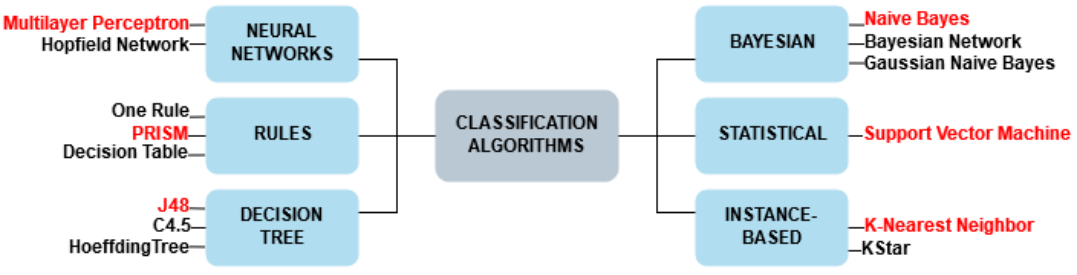
Figure 2. Classification task learning